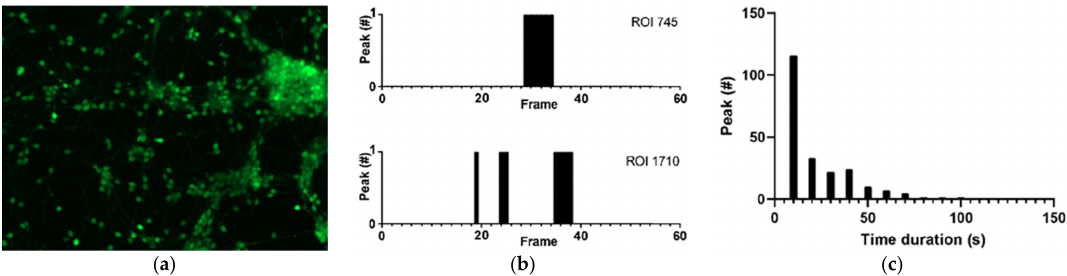
Figure 3. Neuronal activity of hiPSCNs on NG-PDMS. ( a ) hiPSCNs loaded with green-fluorescent Fluo-4 AM. Magnification x20. ( b ) Active calcium spikes (calcium level is above peak threshold) displayed by black columns in two ROIs. ( c ) Calcium spike durations of all ROIs displaying calcium spikes.